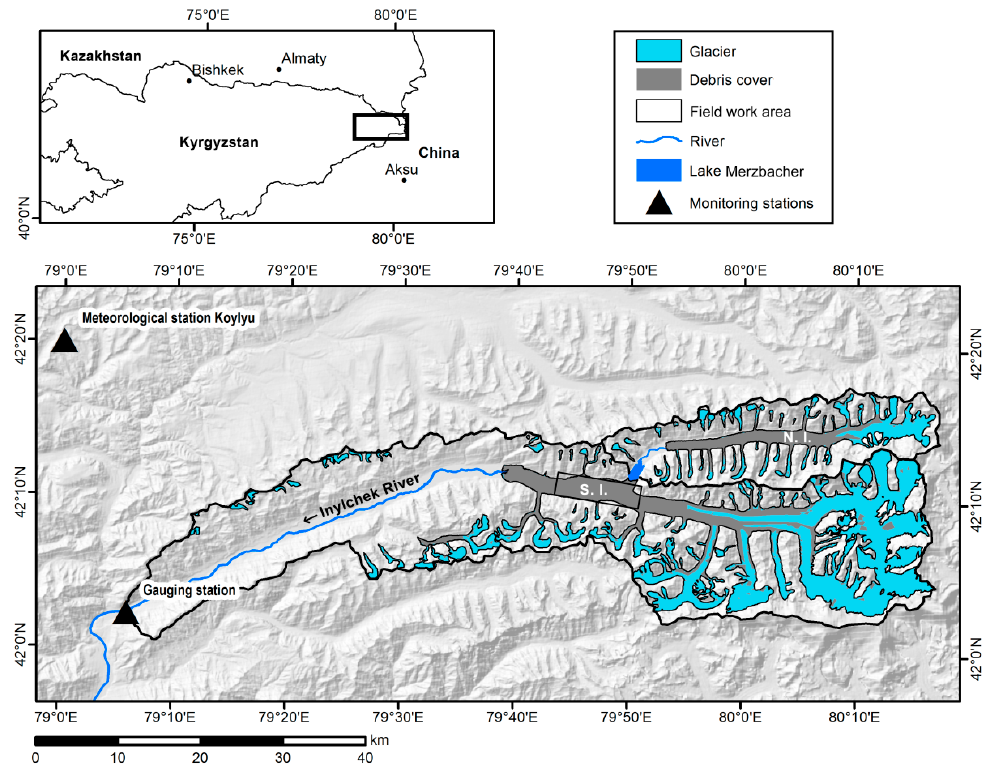
Figure 1. The Inylchek glacier basin with Southern Inylcheck (S.I.) and Northern Inylchek (N.I.) glaciers. The background is a hillshade of the Shuttle Radar Topography Mission (SRTM3) elevation model [52].